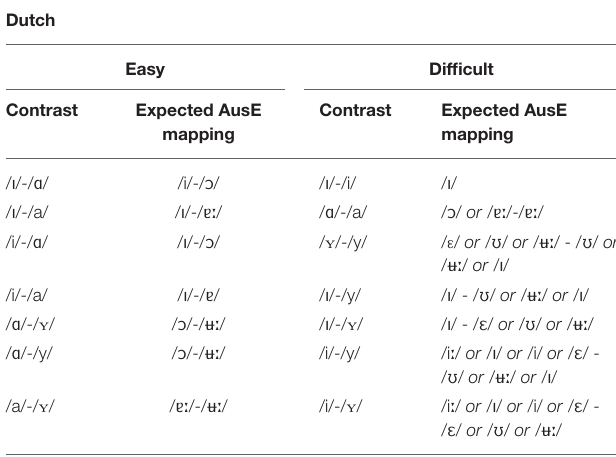
TABLE 2 | Easy and difficult vowel mappings of Dutch vowels to AusE vowels. Dutch Easy